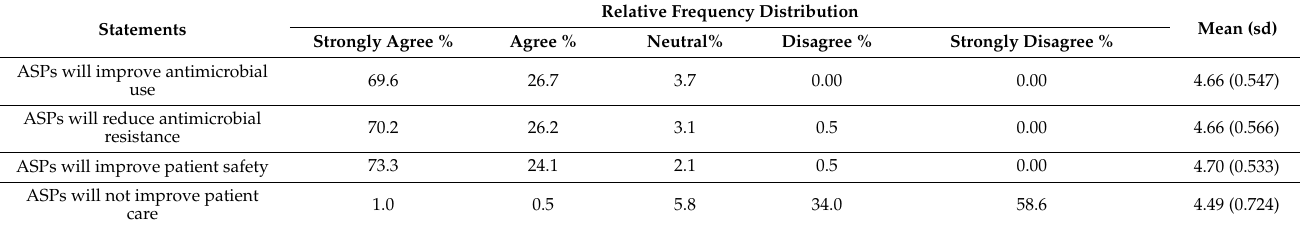
Table 3. The participants’ perceived benefits and usefulness of